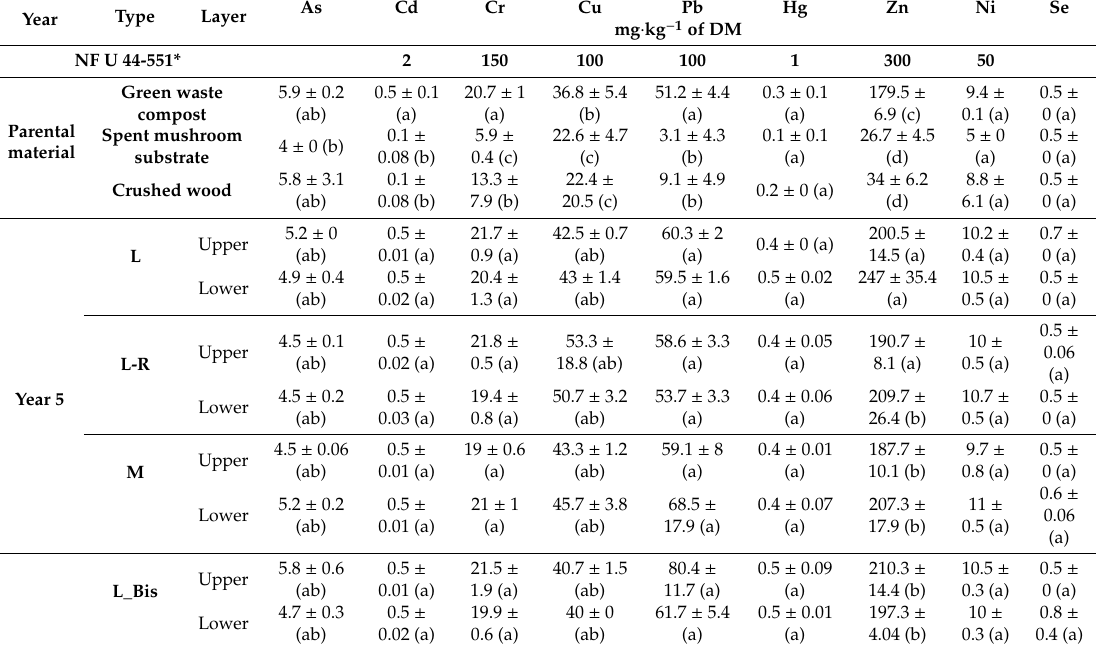
Table 6. Trace metal contents in Technosol and parent material. *NF U 44-551: AFNOR standard regarding potting